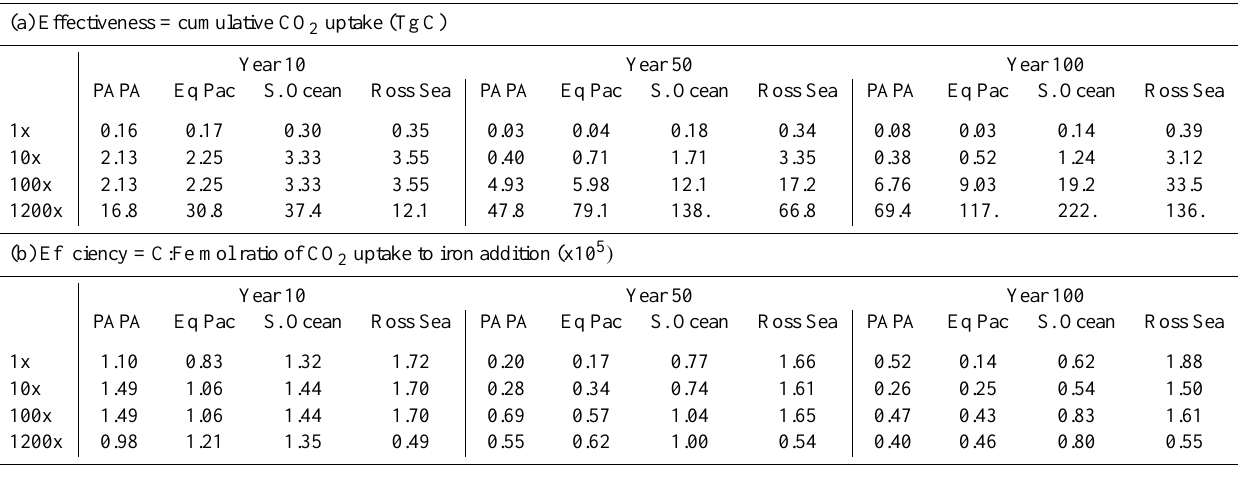
Table 5. Effectiveness and efficiency of CO 2 uptake from the